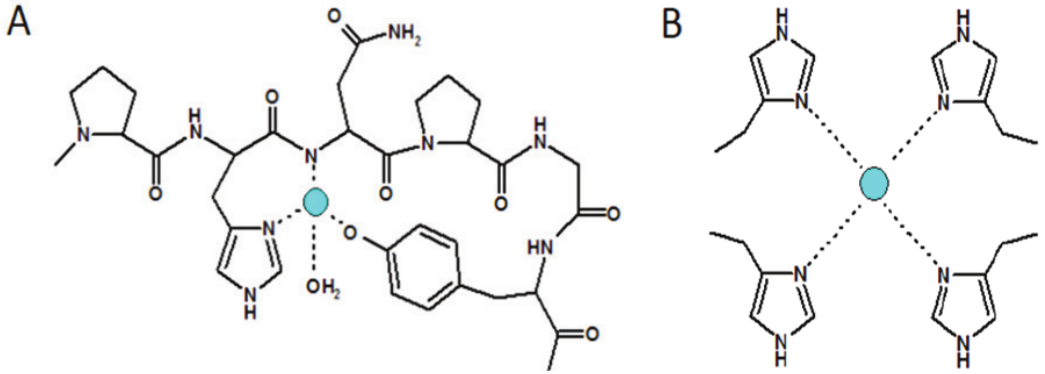
Figure 4. Sketches of different copper coordination modes with ( A ) chicken